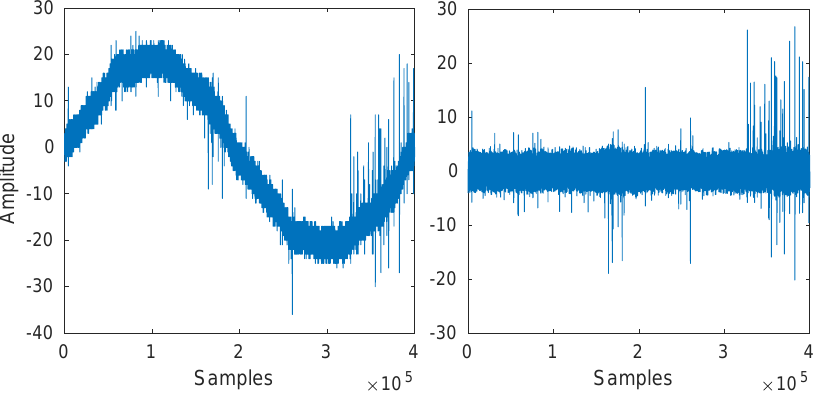
Figure 3. Signal processed by Butterworth filtering. Raw signal ( left ) and filtered signal ( right ) after using of high-pass filter to suppress the sine shape.